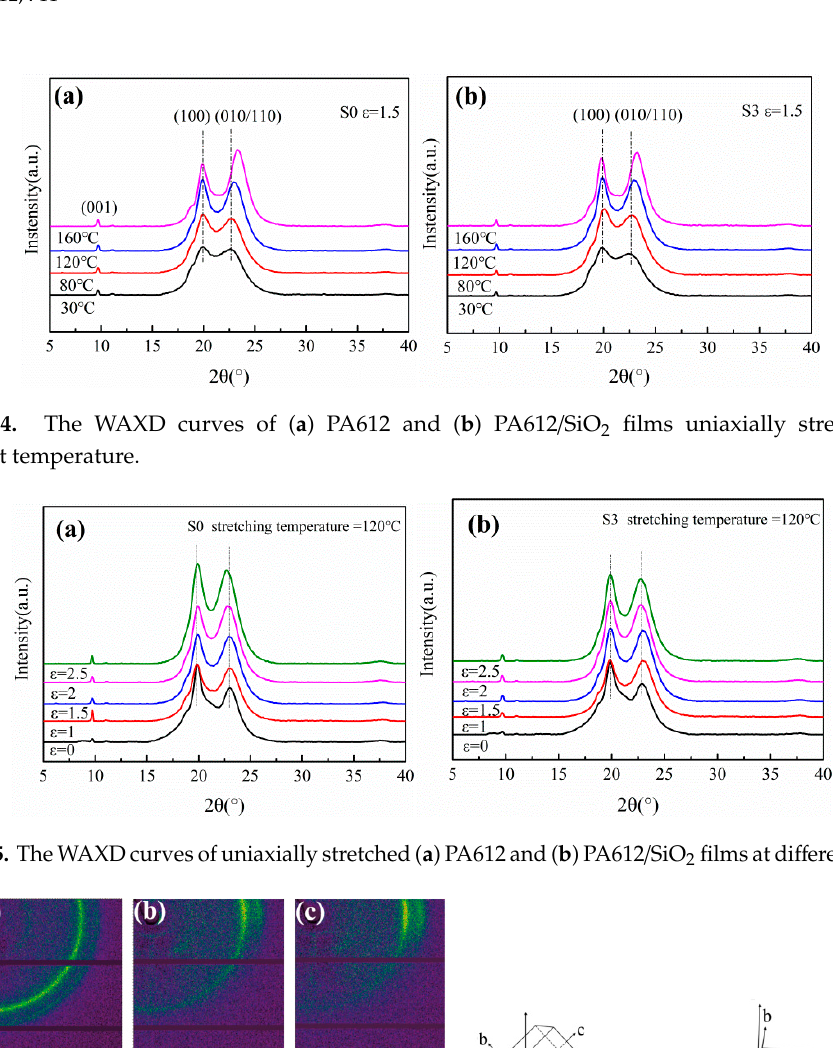
Figure 4. The WAXD curves of ( a ) PA612 and ( b ) PA612/SiO 2 films uniaxially stretched at different temperature.